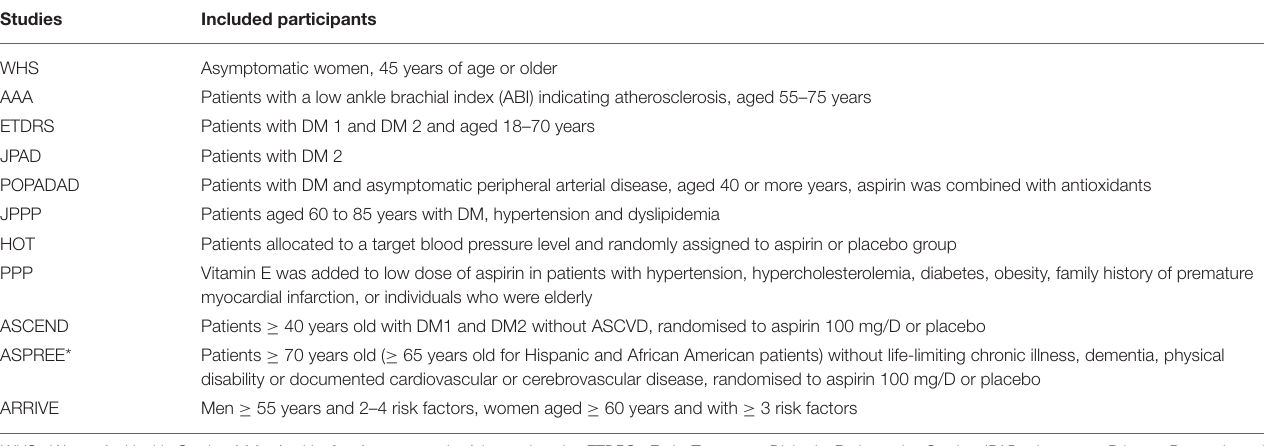
TABLE 1 | Randomized control trials included in the